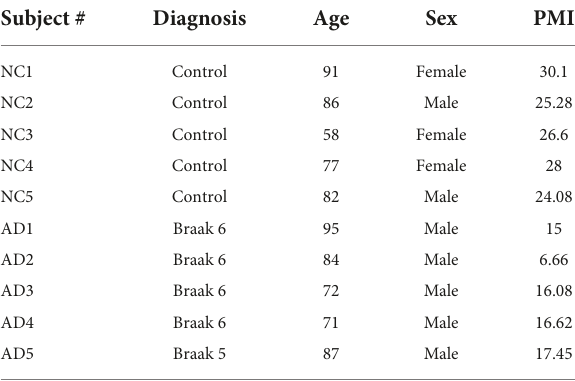
FIGURE6 IQCK protein levels are significantly increased in the hippocampus of AD brains relative to NC brains by immunoblots. IQCK protein levels were normalized to actin levels used as loading controls, quantified by ImageJ, and compared between NC and AD. Relative to NC, the AD hippocampus showed 109% increase in IQCK levels. Data were statistically analyzed by paired t -test. **, p < 0.01; data are expressed mean + SEM, n = 5 per group.